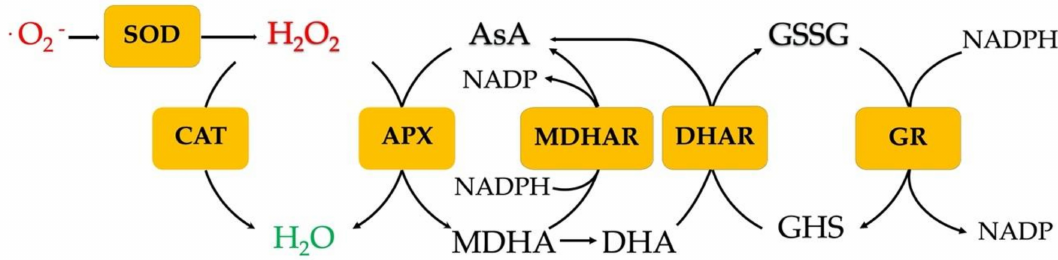
Figure 1. Enzymatic and nonenzymatic active antioxidants in plant defense and the Foyer- Halliwell-Asada cycle (also known as the AsA-GHS cycle) with its intermediates are reported. The Foyer-Halliwell-Asada cycle starts with the reduction of hydrogen peroxide in water by ascorbate peroxidase(APX).Abbreviations: SOD,superoxidedismutase; CAT,catalase; APX,ascorbateperoxidase; MDHAR, monodehydroascorbate reductase; DHAR, dehydroascorbate reductase; GR, glutathione reductase; MDHA, monodehydroascorbate reductase; DHA, dehydroascorbate reductase; GHS, reduced glutathione; and GSSG, glutathione